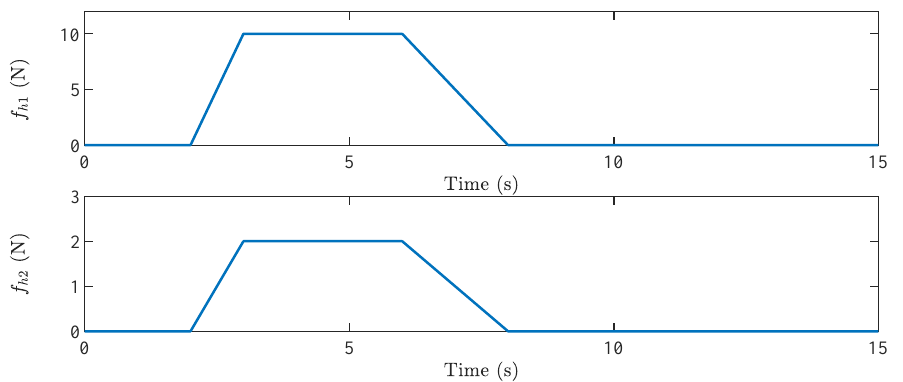
Figure 3. Forward and backward time varying delays d m and d s .